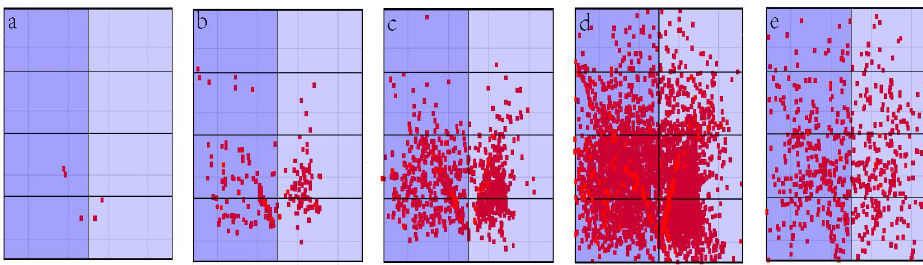
Figure 6. AE locations in sample SA-2 during different deformation stages; ( a ) compression fissures stage; ( b ) linear deformation stage; ( c ) stabilized-growth crack stage; ( d ) accelerated-growth cracks stage and ( e ) after peak stress stage. The purple part was the rock sample; the black grid helped to locate AE positions; the red spots represented the location of AE enents.